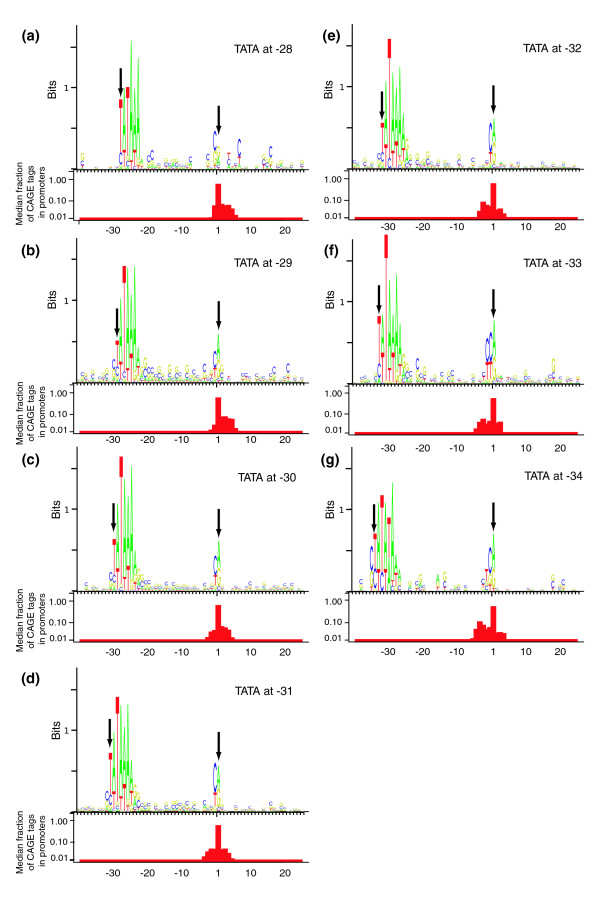
TATA-TSS spacing is correlated with promoter and initiation site characteristics. (a-g) Sequence logos [43] for promoters divided into spacing subclasses based on the location of the most prominent TATA box. CAGE tag distribution trends in each spacing subclasses are shown below each logo; specifically, the median fraction of CAGE tags within each promoter for each spacing class is plotted using a log-scaled y-axis (see Materials and methods). The locations of the dominant TSS and the TATA-box start are indicated with black arrows. Both the initiation site (positions -3 to +1) consensus and CAGE tag distributions differ between the different classes. Of particular interest is the extended initiation site motif for promoters located at -33 and -34, as well as the different consensus for promoters with TATA boxes located at -28. The CAGE tag distribution is skewed in a direction that is consistent with alternative start sites at a more favorable spacing (closer to position -30 or -31). CAGE, cap analysis of gene expression; TSS, transcription start site.